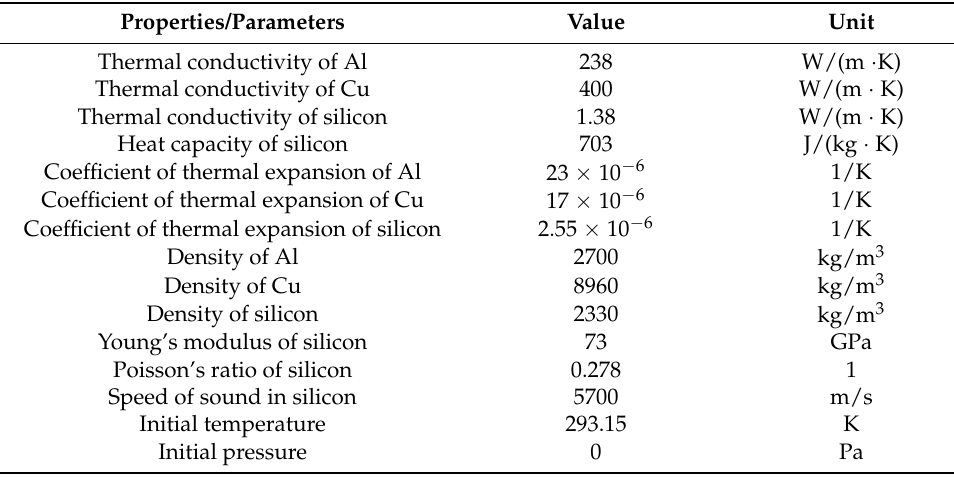
Table 1. Properties at T ≈ 293 K and parameters used in numerical modeling. Properties/Parameters Value Unit Thermal conductivity of